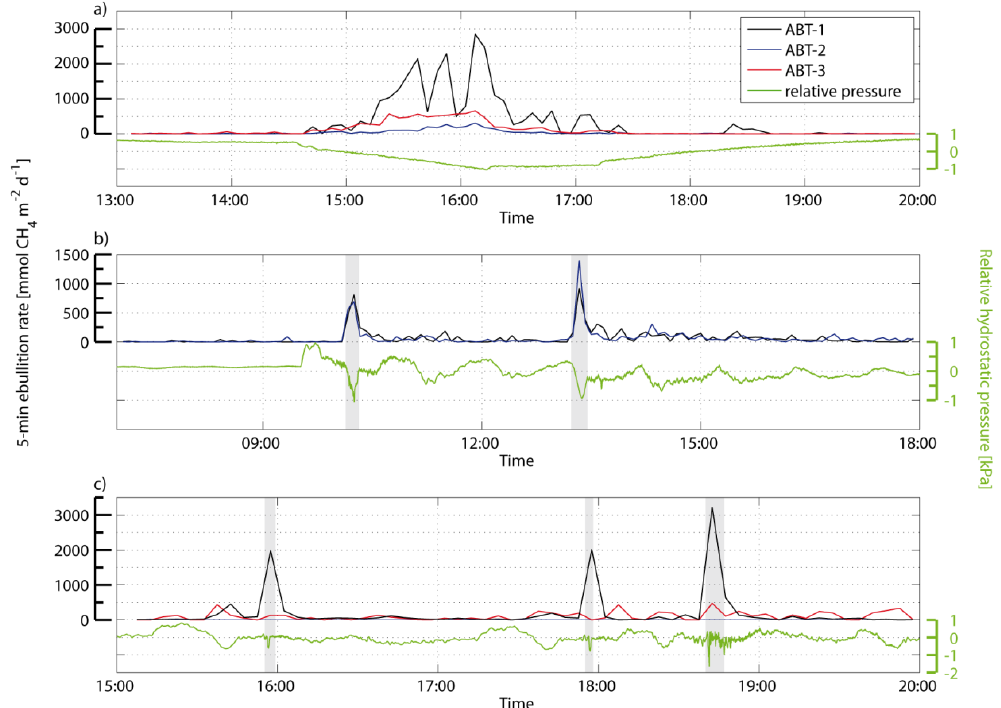
Figure 8. Time series of 5min ebullition rates and hydrostatic pressure changes. Panel (a) shows bubble release during sinking water level Fig. 8: Time series of 5-min ebullition rates and hydrostatic pressure changes. Panel a) shows bubble release 628 within a high-discharge period (25 December 2012). Panel (b) shows the relationship between positive and negative (grey shaded) surges during sinking water level within a high-discharge period (25 December 2012). Panel b) shows the relationship 629 and the ebullition rates (31 October 2012), while panel (c) highlights ebullition during the corresponding ship passages (grey shaded) (18 between positive and negative (grey shaded) surges and the ebullition rates (31 October 2012) while panel c) 630 February highlights ebullition during corresponding ship-passages (grey shaded) (18 Febuary 2013). 631